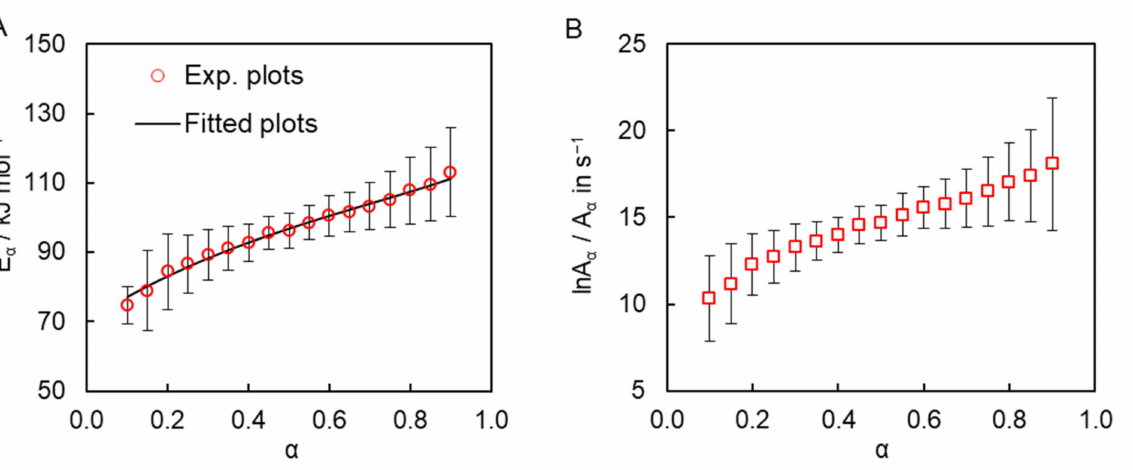
Figure 4. Dependence of activation energy with the best fit of Equation (9) ( A ) and pre-exponential factor ( B ) as a function of conversion for the solution polymerization of cyanate